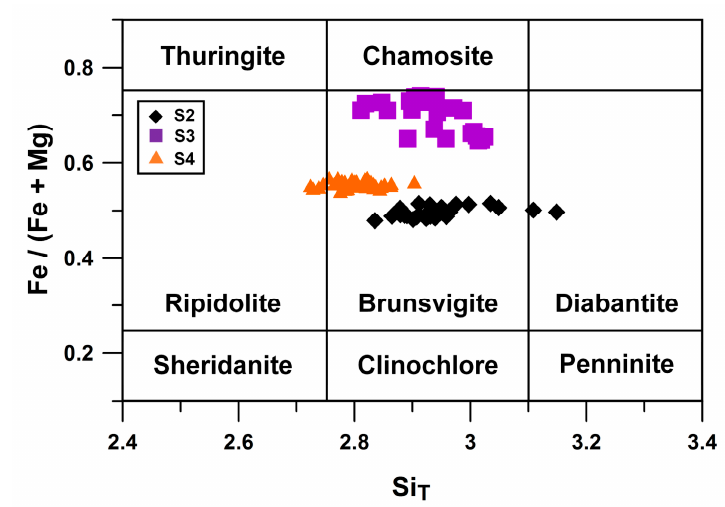
Figure 6. Chlorite classification plot of chlorites from Sangdong W-deposit. The x-axis represents the calculated Si 4 + composition of the chlorite. The y-axis represents the ratio of Fe in chlorite. Overall composition lies in brunsvigite; few exist as ripidolite and diabantite. Each stage shows a different Fe ratio range.